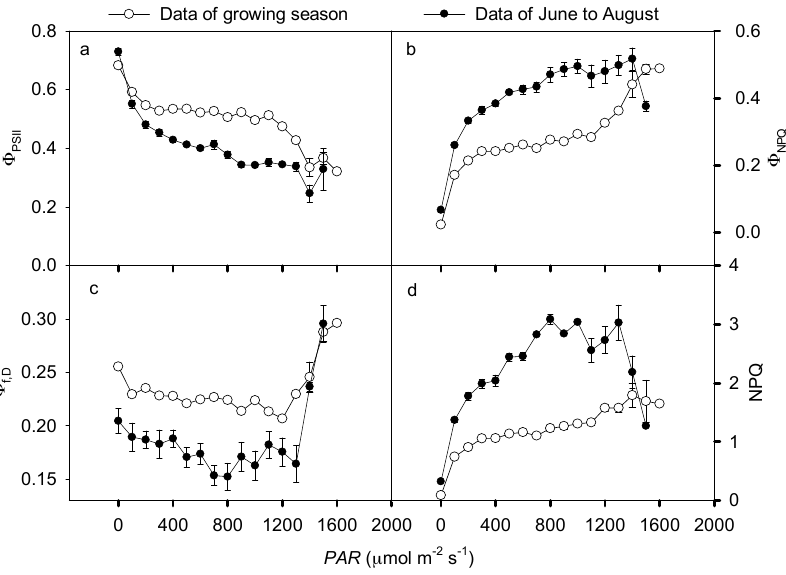
Figure 4. Actual quantum yield of PSII photochemistry ( Φ PSII , ( a )), regulated thermal energy loss ( Φ NPQ , ( b )), non-regulated energy loss ( Φ f,D , ( c )), and non-photochemical quenching coefficient (NPQ, Stern-Volmer quenching, ( d )) in Salix psammophila as a function of photosynthetically active radiation ( PAR ) during the growing season of 2012. Data points of energy partitioning and NPQ represent bin-averaged values. Here, the bins are set at 100 µ moL · m − 2 · s − 1 increments of PAR with a minimal sample size of six. The open and closed circles represent averages of data collected over the entire growing season and summer period, respectively. The error bars denote standard error.